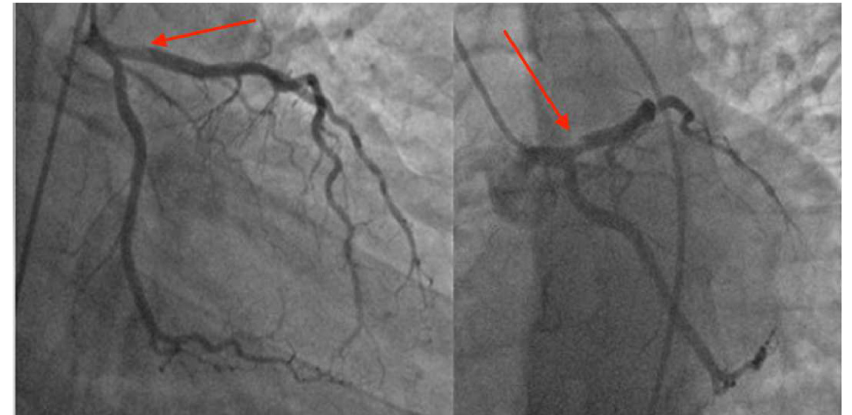
Figure 3. Coronary angiography showed an acute thrombotic type 1 dissection of the proximal left descending artery with TIMI III blood flow.